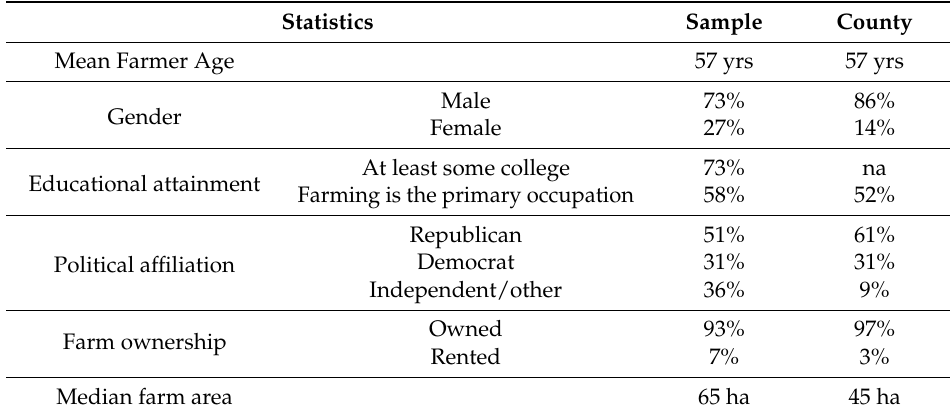
Table 1. Characteristics of the Allegany County (NY) farmer respondents in this study ( n = 45) and of Allegany County farmers as a whole